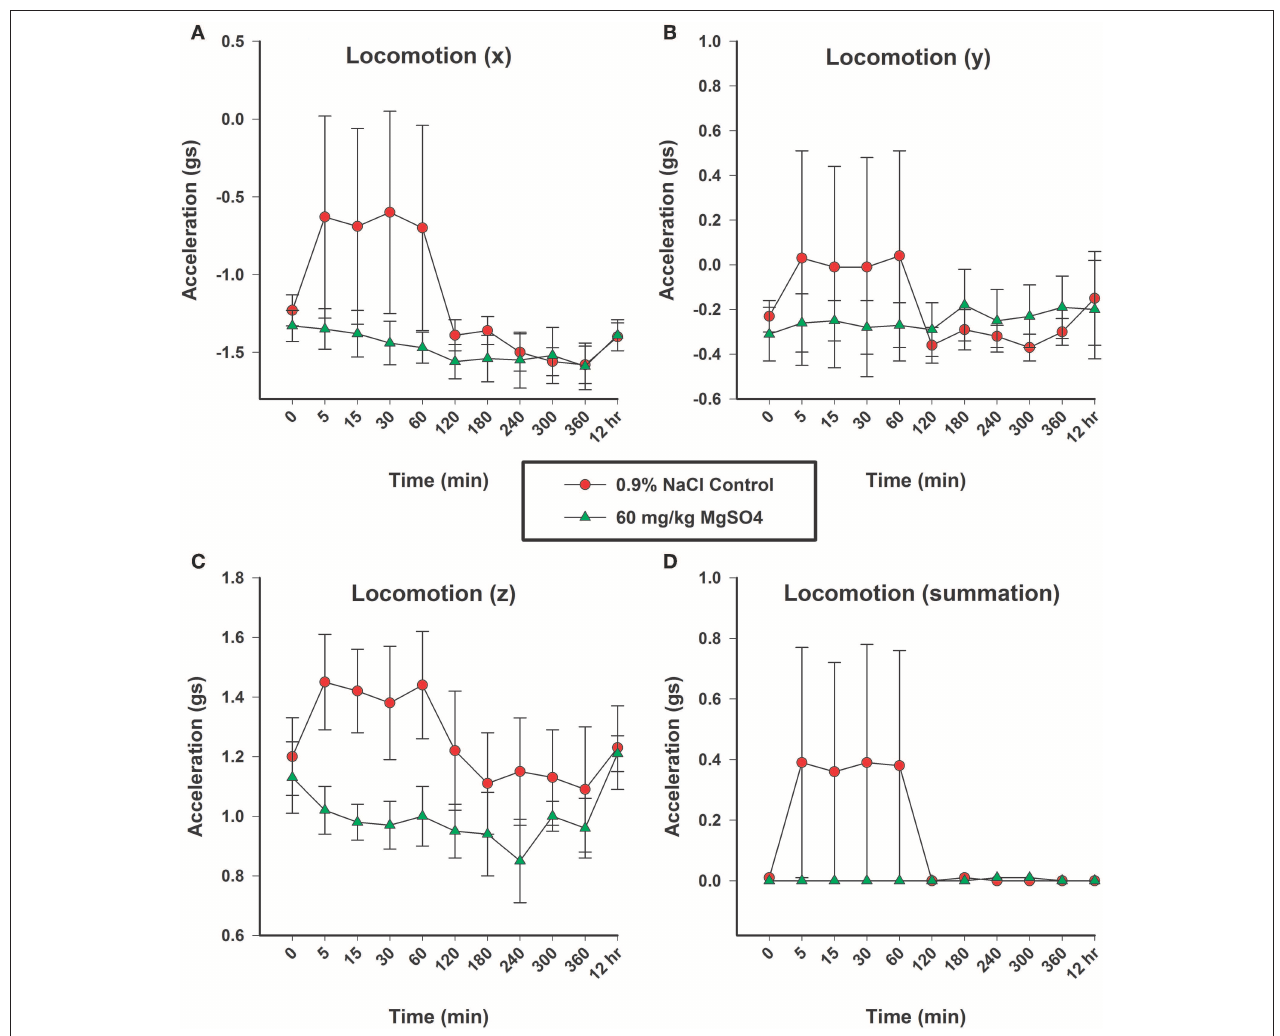
FIGURE 7 | Locomotion as measured in three planes (x, y, and z) by acceleration (gs), using accelorometers housed in the base transmitter located on the withers; (A) x-vector plane, (B) y-vector plane, (C) z-plane, and (D) overall locomotion. Horses received MgSO 4 intravenously (green triangles) or an equivalent volume of 0.9% NaCl (red